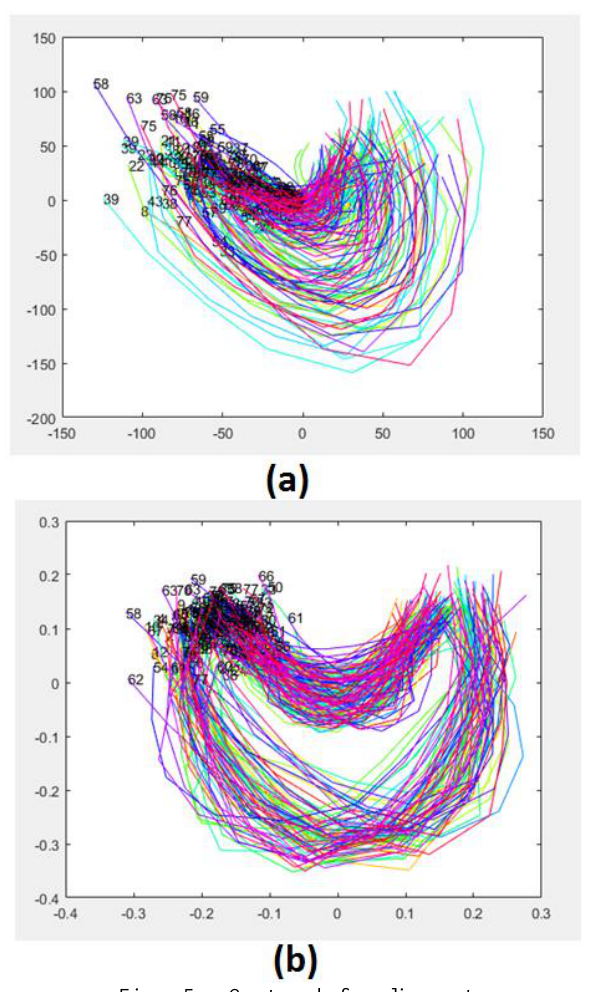
Figure 5: a: Contours before alignment b: Contours after Procrustes alignment